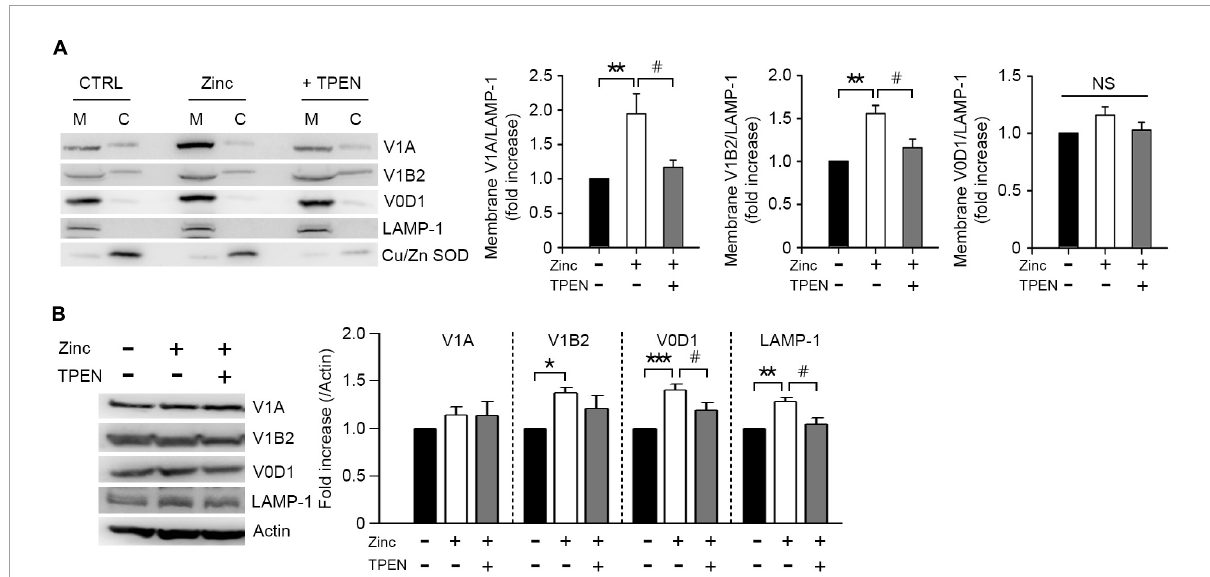
FIGURE6 Zinc promotes vacuolar-type H + –ATPase assembly. Western blot analysis for the membrane and cytosolic distribution (A) and expression (B) of V1 and V0 subunits of V-ATPase in mouse cerebrocortical cultures. Protein samples were prepared at 1 h after exposure to sham wash (CTRL) or 25 µ M ZnCl 2 (Zinc) with or without TPEN. Total protein extracts were used for expression level (B) and then separated into membrane (M) and cytosolic (C) fractions (A) . Antibodies against V1A or V1B2 were used for V1 subunit, and V0D1 was used for V0 subunit of V-ATPase. LAMP-1 and Cu/Zn-SOD were used for verification of the quality of membrane and cytosolic separation. Bar graphs (A) represent the ratio of V1A, V1B2, or V0D1 to LAMP-1 level in the membrane fraction (mean ± SEM, taken from ≥ 4 independent experiments). ** p < 0.01 vs. sham wash control and # p < 0.05 vs. zinc alone by ANOVA with post hoc Dunnett’s test. There was no significant difference in V0D1 levels on the membrane (NS). Expression levels of V1A, V1B2, V0D1, and LAMP-1 (B) . Quantification was made in ≥ 3 independent biological replicate experiments. * p < 0.05, ** p < 0.01, or *** p < 0.001 vs. sham wash control and # p < 0.05 vs. zinc alone by ANOVA with post hoc Dunnett’s